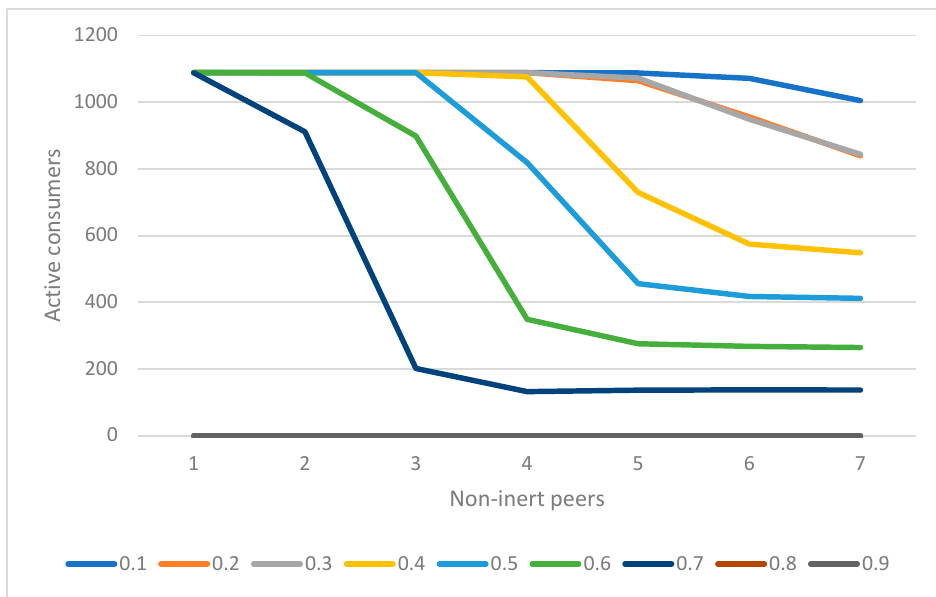
Figure 7. Consumer activity at moderate (medium) influence.